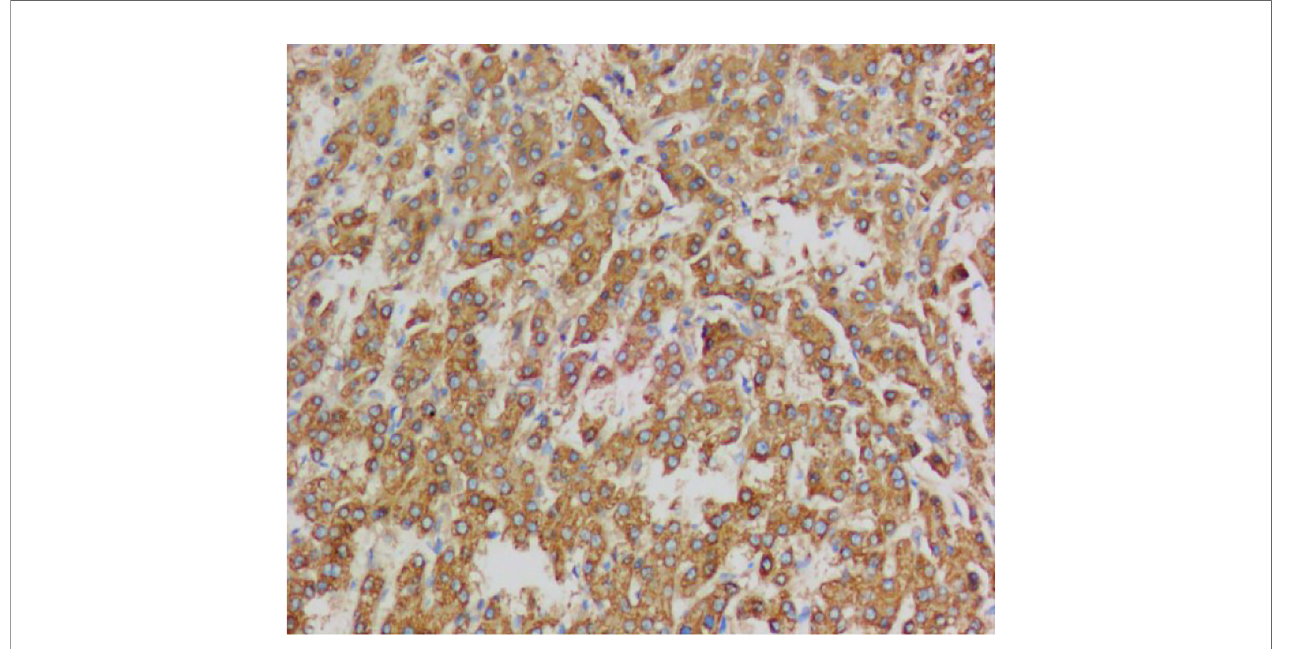
FIGURE 6 | Immunohistochemistry showed